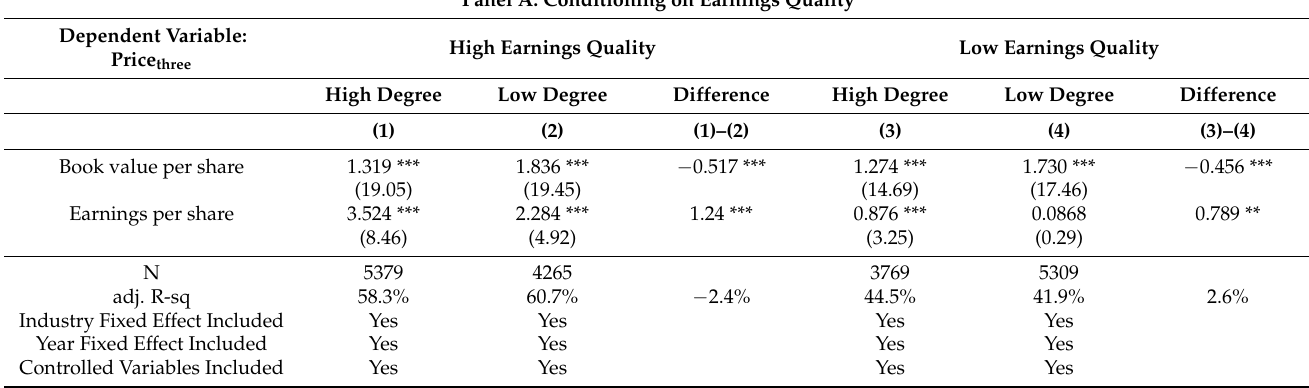
Table 6. CEO social capital and the value relevance of accounting metrics: Second-order effect. This table presents the results of the OLS regressions explaining the effect of CEO social capital on the value relevance of book value of equity and earnings metrics, controlling for earnings quality in Panel A, accounting conservatism in Panel B, investment efficiency in Panel C. In all panels, the dependent variable is Price three , a continuous variable measured by the market price of the common equity at the end of three months after fiscal year-end. CEO social capital is measured by Degree in columns (1) to (4), Eigen in columns (5) to (8) and PCA in columns (9) to (12); variables of interest in the regression include Book value per share (book value of common equity scaled by number of shares outstanding) and Earnings per share (net income scaled by number of shares outstanding). All regressions include control variables as defined in Appendix A. For brevity, the table only presents coefficients related to the variables of interest. All regressions include time- and industry-fixed effects and the errors are robust to firm heteroscedasticity. T-values are reported in parentheses. Statistical significance of the coefficients is designated as ***, ** and * at 1%, 5% and 10% levels,